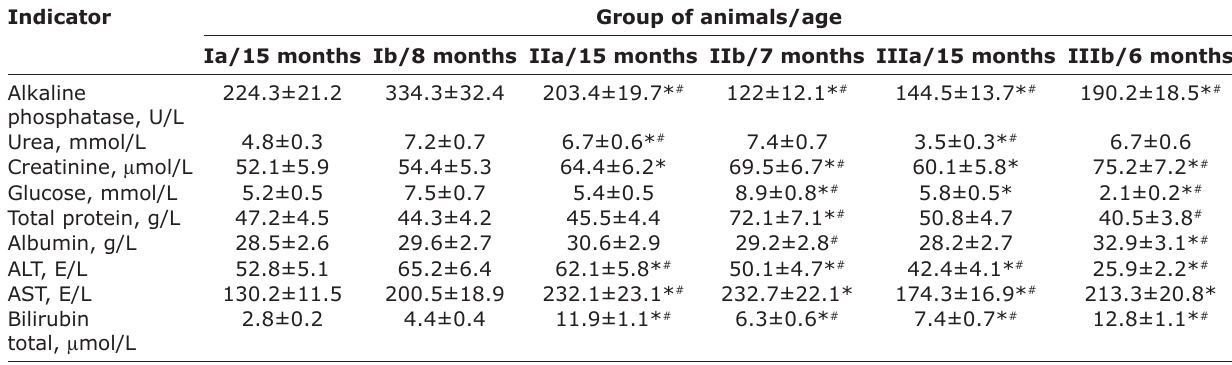
Table-7: Biochemical indices of rat blood (experiment of 9 months). Indicator Group of animals/age